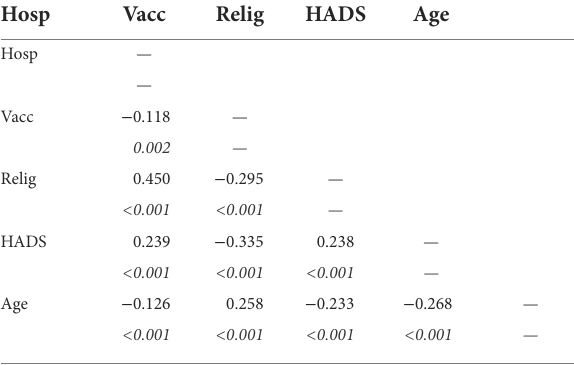
TABLE 4 Correlations (with probabilities in italics) among the measures of the reduced model of vaccination. Hosp Vacc Relig HADS Age